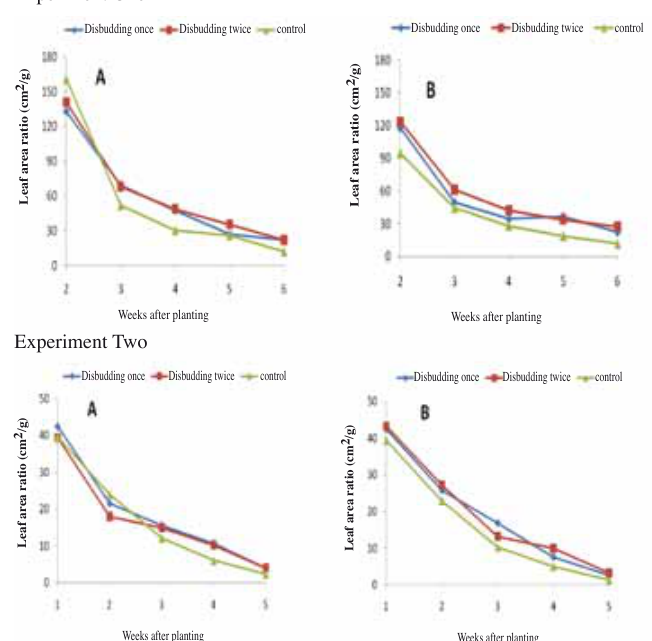
Fig. 7 - Leaf area ratio as affected by disbudding and cultivar: ‘Carmi - ne’ (A) and ‘Chief Gold’ (B).